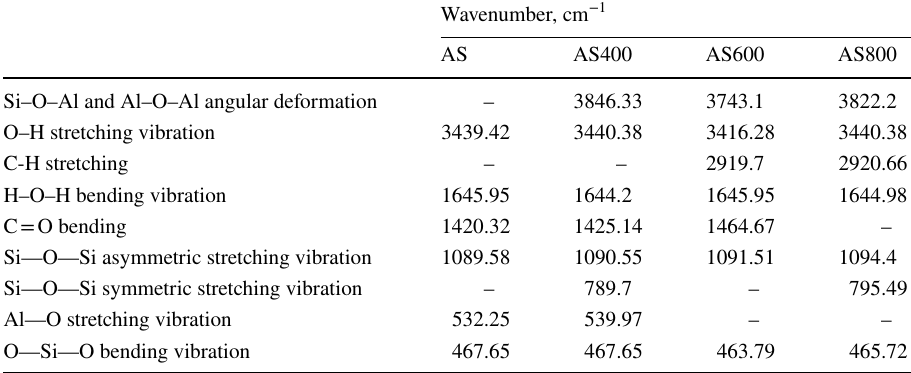
corresponding adsorption bands in FTIR of different alum sludge calcined temperature